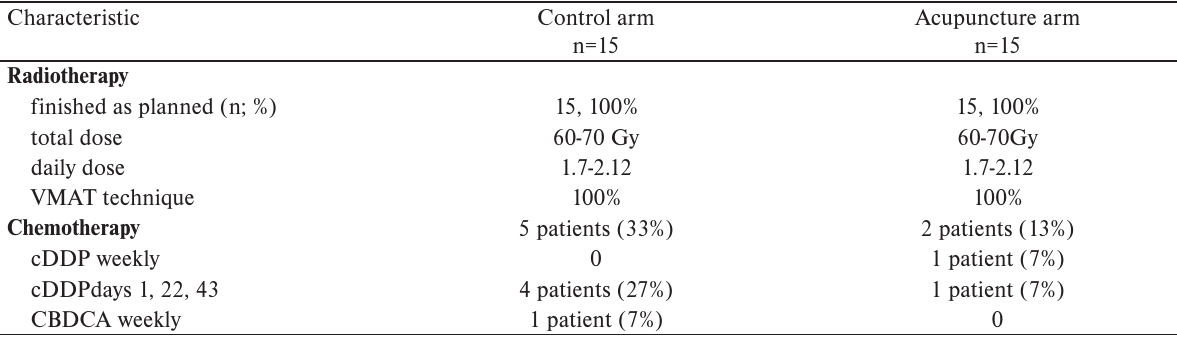
Table 4. Treatment details.